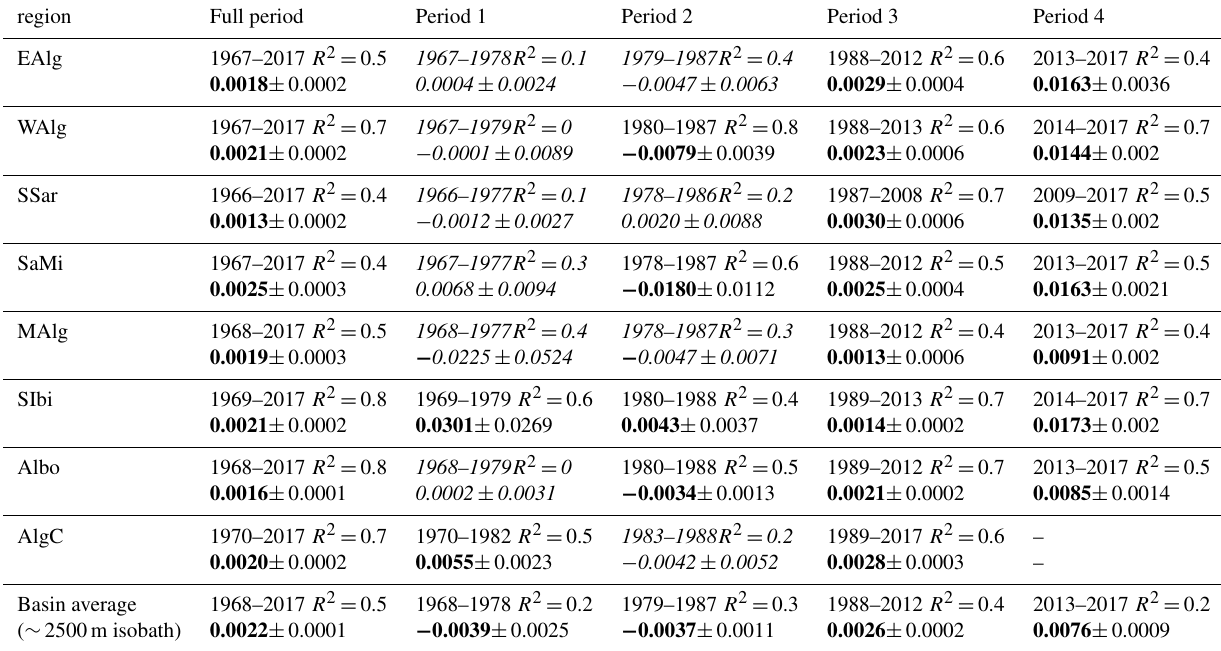
Table 2. Same as Table 1 for LIW